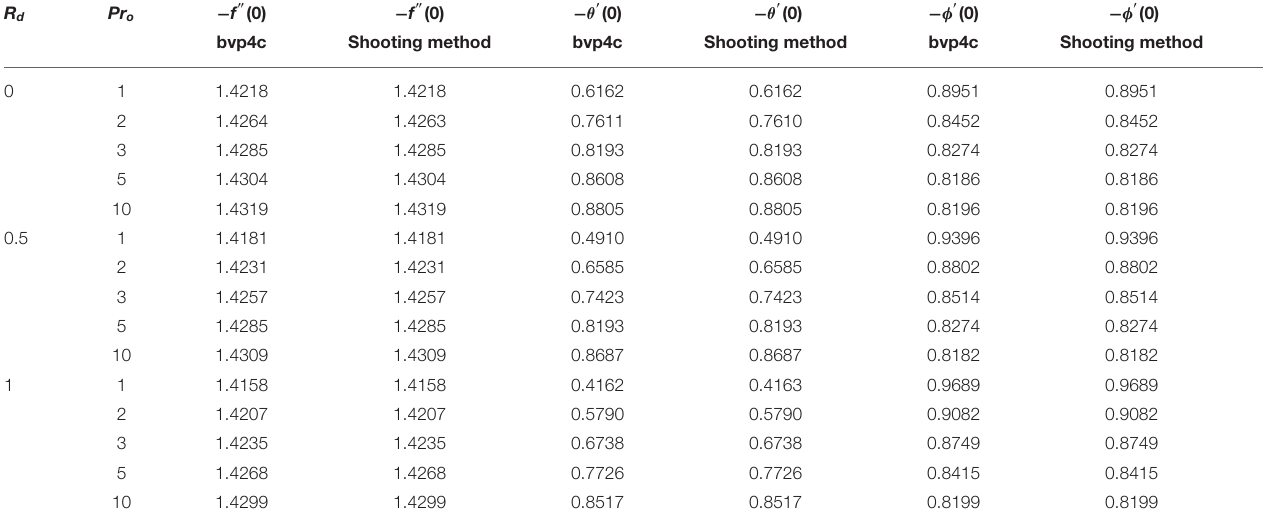
λ ǫ 0, θ r 5, N b 0.8, N t 0.5, L e 1.3. = = = = − = = =